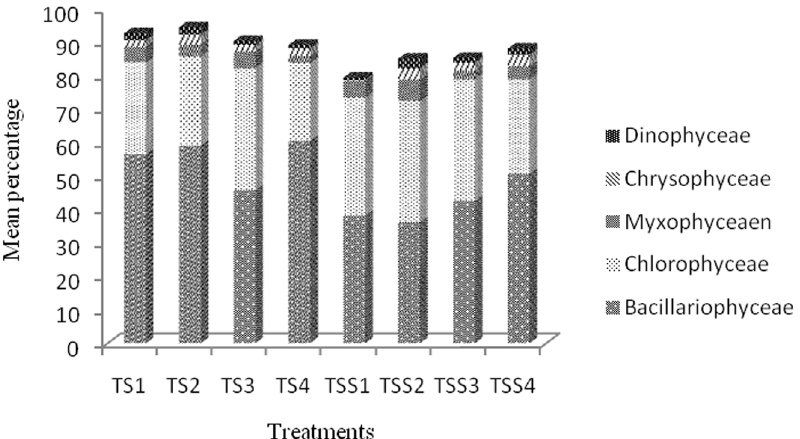
Fig. 3. Percentage compositions of algal forms at surface (TS1 – TS4) and subsurface (TSS1 – TSS4) levels of ponds among four different treatments during the study